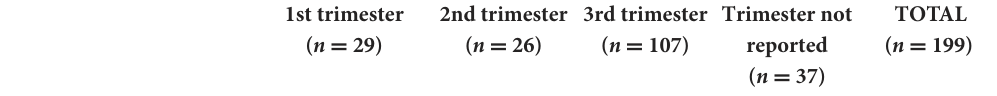
TABLE 1 Characteristics, indications and timing of insertion of inferior vena cava filters during pregnancy. Indications for